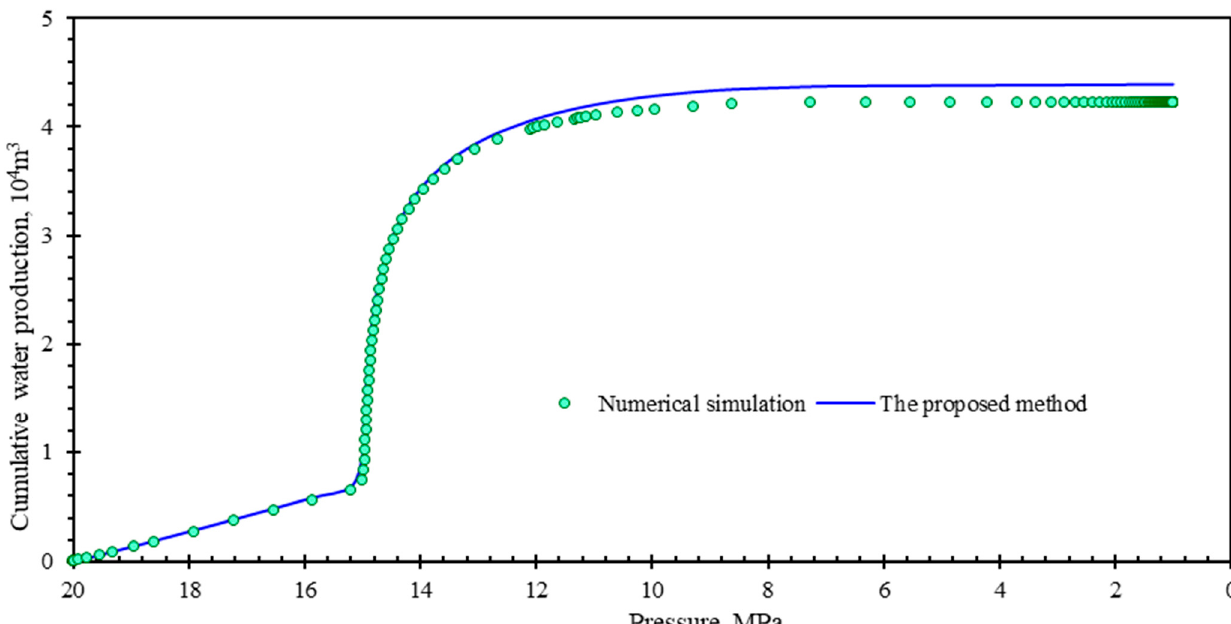
Figure 10. Comparison results of cumulative water production with numerical simulation.